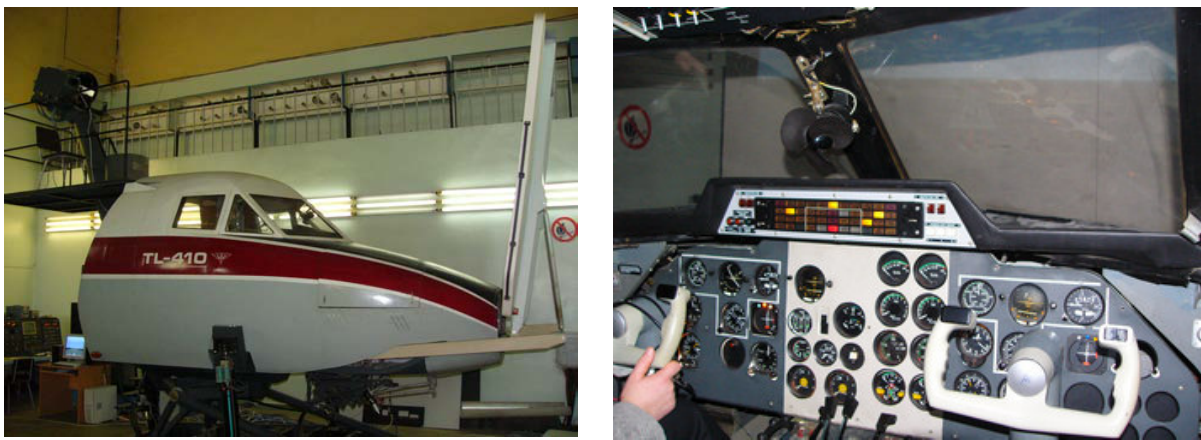
Fig 3. TL-410M functional flight simulator Fig 4. TL-410M functional flight simulator